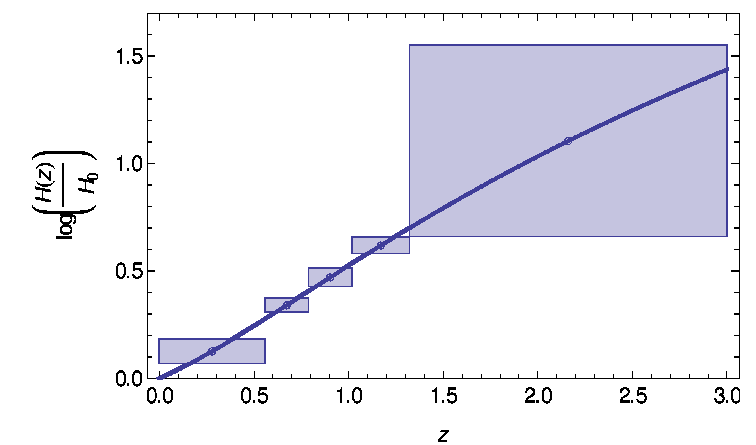
Fig. 25 Error bars on the Hubble parameter H ( z ) with five redshift bins. The exact height of the error bars respectively are ( 0 . 23 , 0 . 072 , 0 . 089 , 0 . 064 , 0 . 76 )